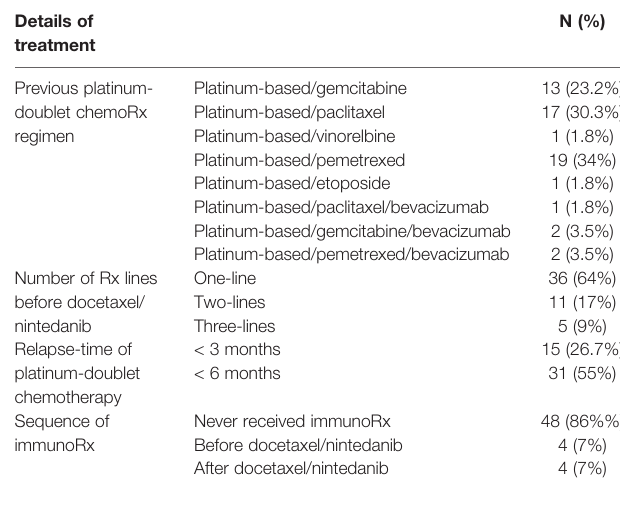
TABLE 2 | Summary treatment of participants in this